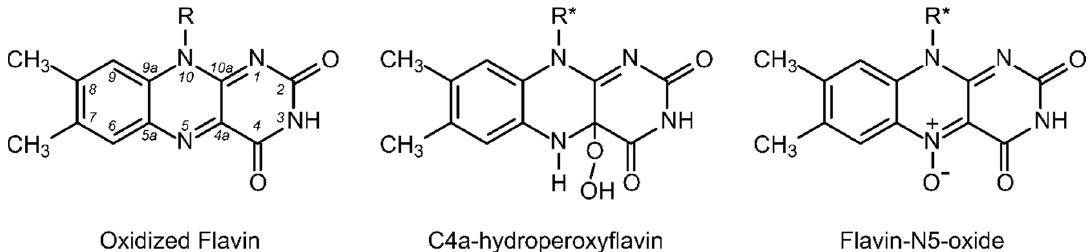
Figure 1. ( left ) Chemical structure of the oxidized form of the flavin isoalloxazine ring system with indication of the atom numbering. ( middle ) Chemical structure of the C4a-hydroperoxyflavin. ( right ) Chemical structure of the flavin-N5-oxide. R = ribityl (Riboflavin), ribitylphosphate (flavin mononucleotide, FMN) or ribityl-ADP (flavin adenine dinucleotide, FAD); R* = ribitylphosphate or ribityl-ADP.